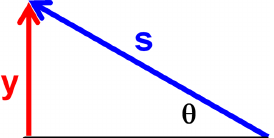
FIG. 13. The relationship between the variables y and s for denoting the position of the rolling sphere in Fig.